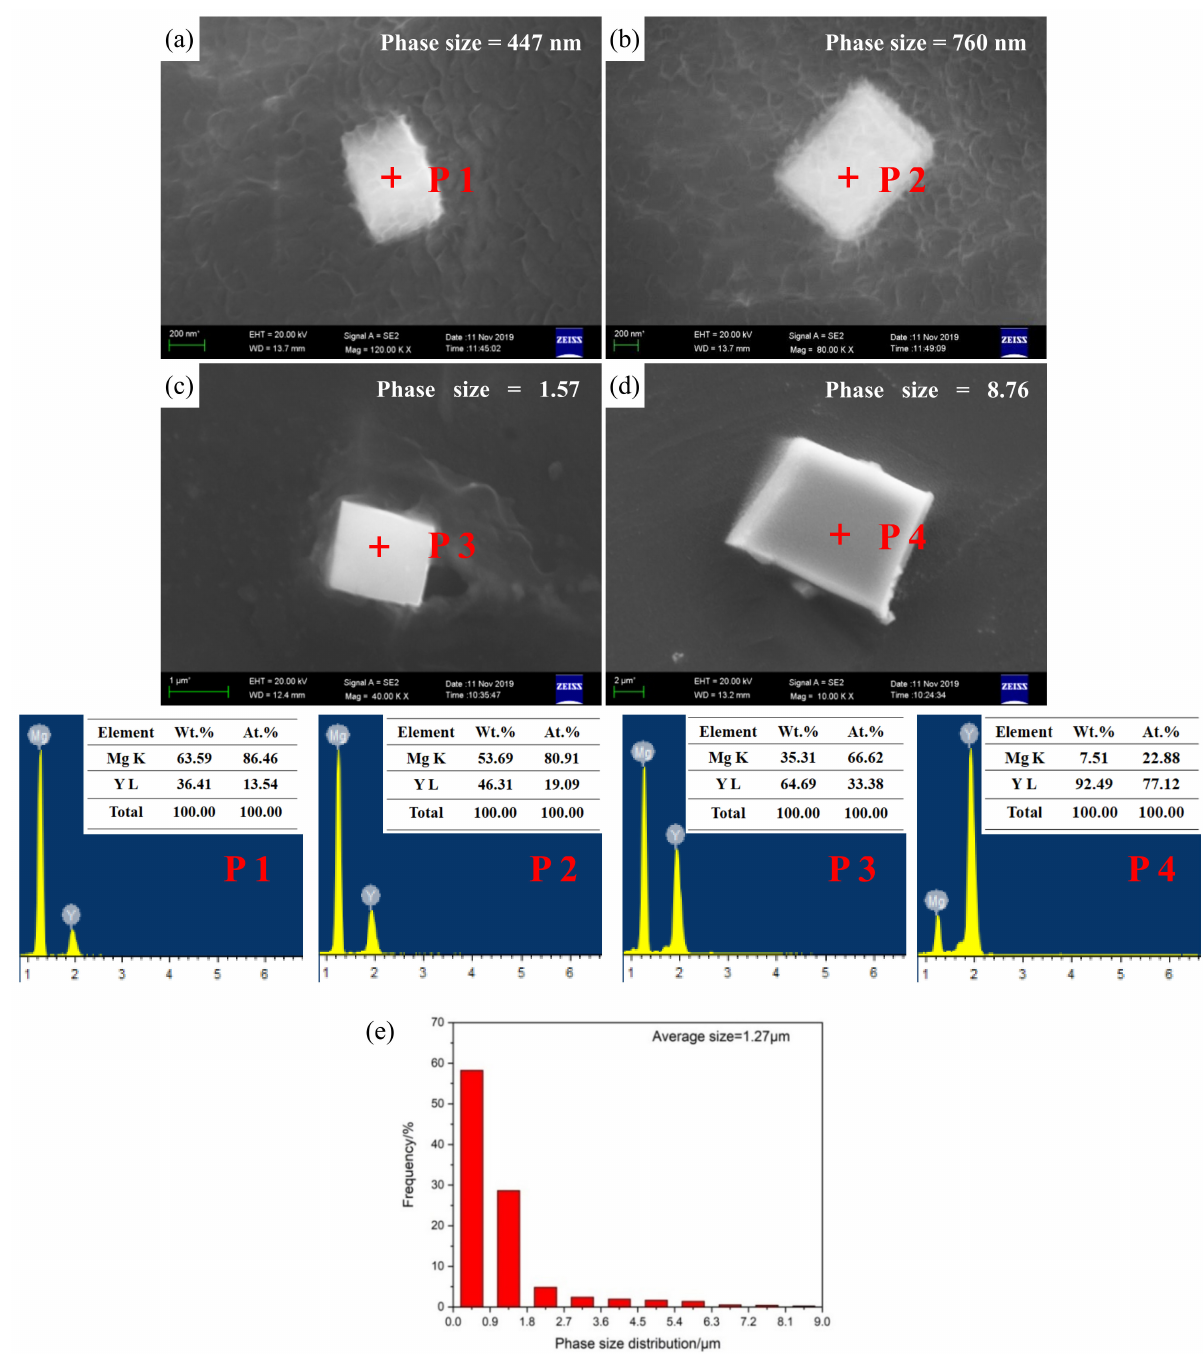
Figure 7. SEM micrographs and EDS results of the secondary phases with different sizes of ( a , b ) nano-scale, ( c , d ) micro-scale, and corresponding phase size distribution histograms ( e ) of as-cast Mg-3Y